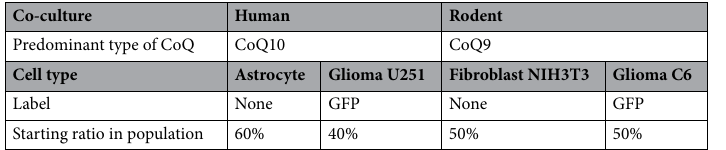
Table 1. Strategy of human and rodent co-culture experiments using glioma and non-tumor cells. In the human cells model, HA (non-labeled) and U251 glioma (GFP-labeled) cells are co-cultured at designated cell densities. In the rodent cells model, NIH3T3 fibroblast (non-labeled) and C6 glioma (GFP-labeled) cells are co-cultured at designated cell densities.